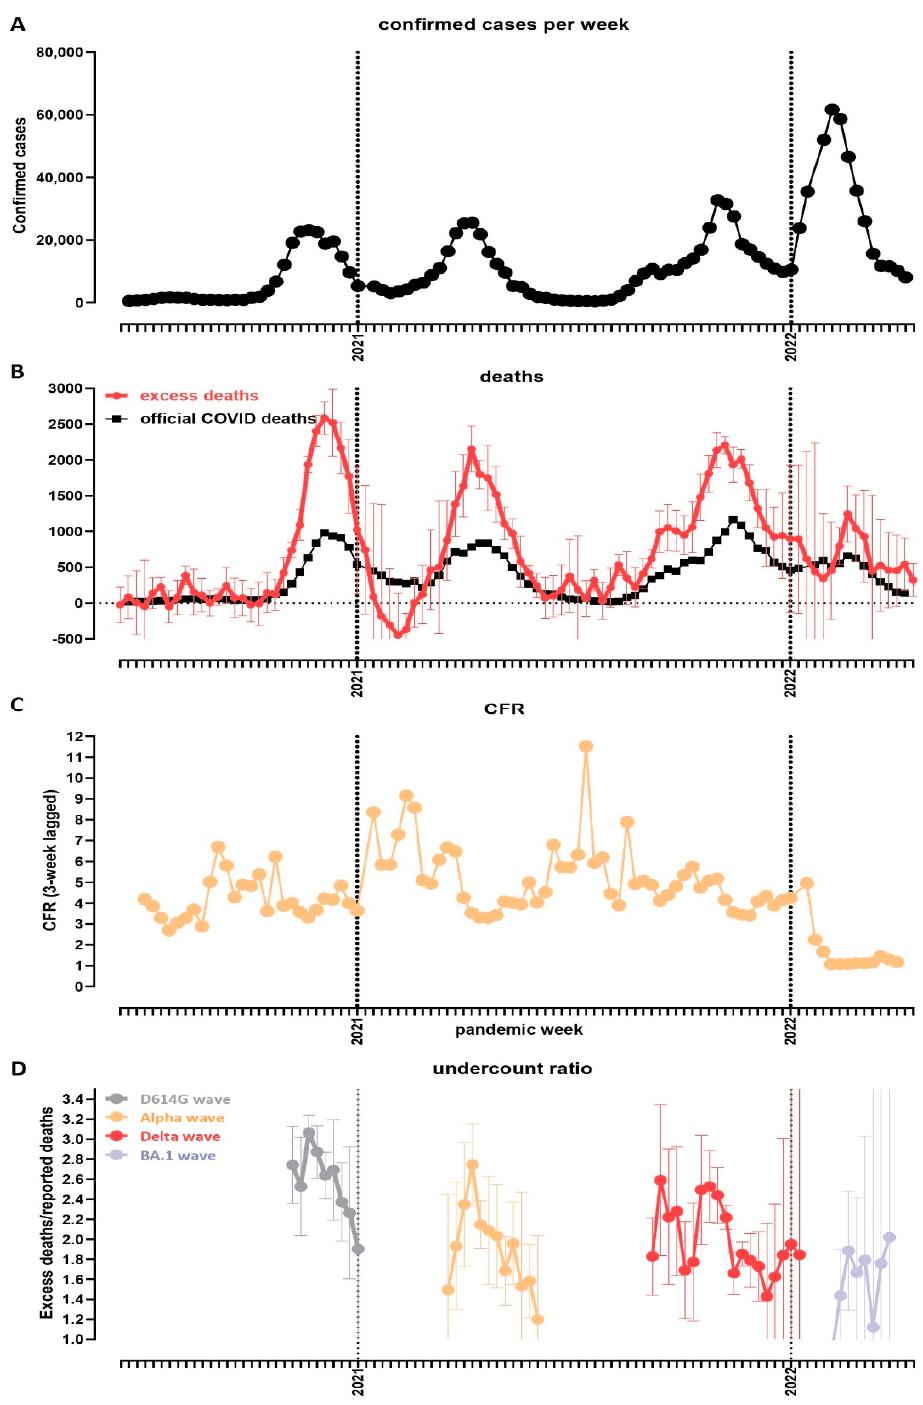
Figure 3. Temporal trajectory of the COVID-19 pandemic in Bulgaria . ( A ) Confirmed cases over time (weekly); ( B ) officially reported and excess deaths over time (weekly); ( C ) CFR over time. Data on reported cases and deaths were obtained from the Our World In Data website [24]. ( D ) Evolution of the undercount ratio (excess mortality divided by official COVID-19 deaths) over time (note that the periods between waves, for which estimates of excess mortality are uncertain, are omitted from the graph).